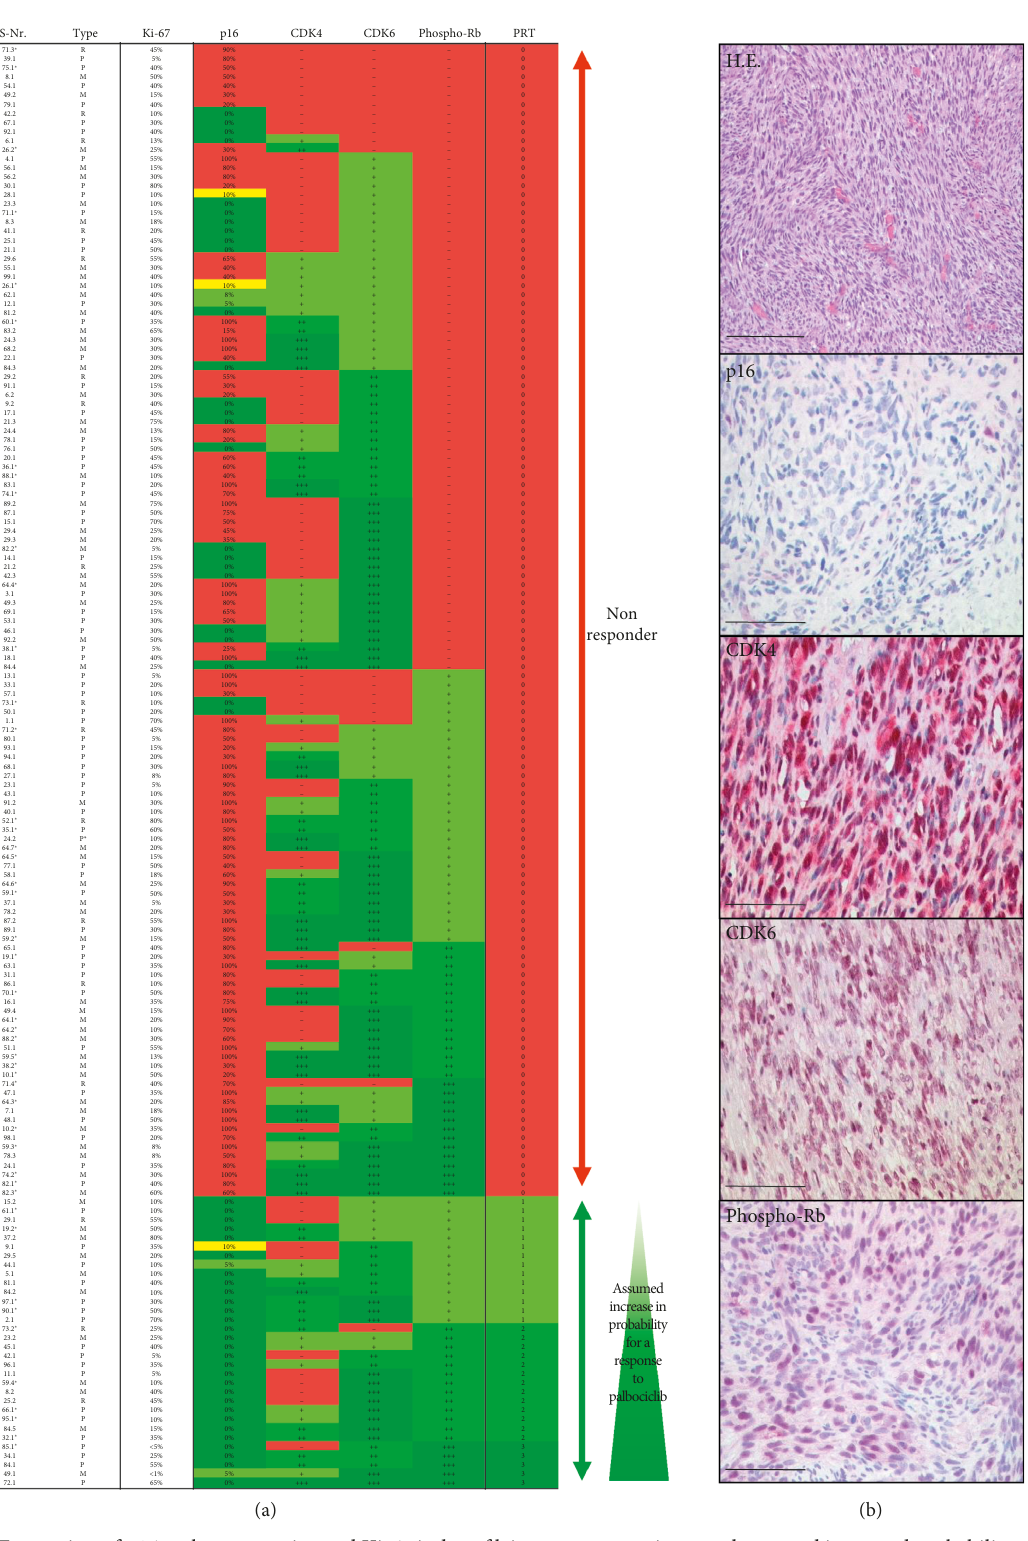
Figure 3: (a) Expression of p16 pathway proteins and Ki-67 index of leiomyosarcoma tissue and assumed increased probability to potential response of palbociclib treatment. Multiple samples from the same patient are marked by their matching sample number (e.g., 6.1 and 6.2); uterine tumours are marked with ∗ . S.-Nr., sample number; PRT, potential responder phenotype; P, primary tumour; M, metastasis; R, recurrence; and P ∗ , primary tumour after neoadjuvant chemotherapy. (b) Exemplary H.E. staining and immunohistochemistry. Negative staining for p16, strong expression of CDK4, CDK6, and p-Rb. Bars: 100 µ m and 200 µ m for